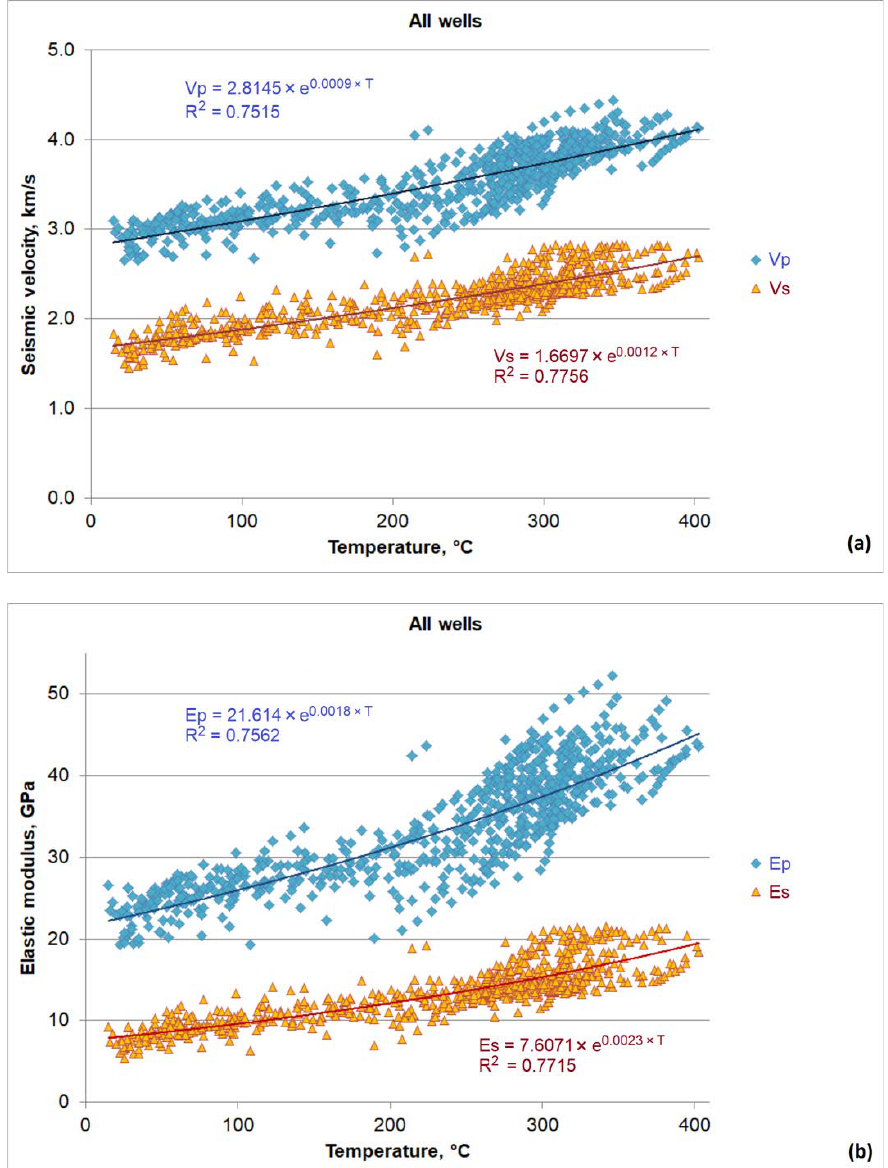
Figure 1. Seismic velocities ( a ) and elastic moduli ( b ), as derived from the passive seismic survey, as a function of natural state temperatures in Los Humeros.